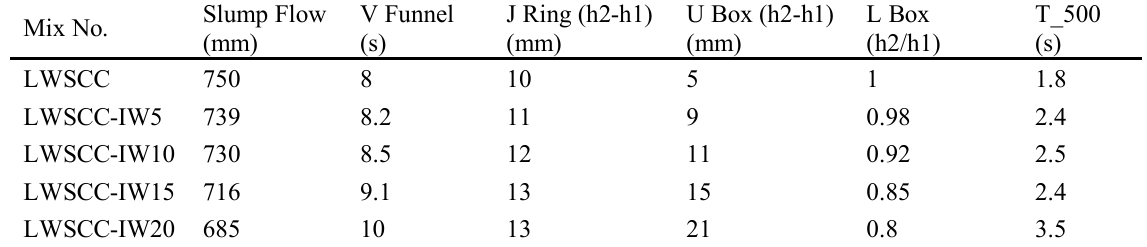
Table 3. Results of fresh concrete tests Mix